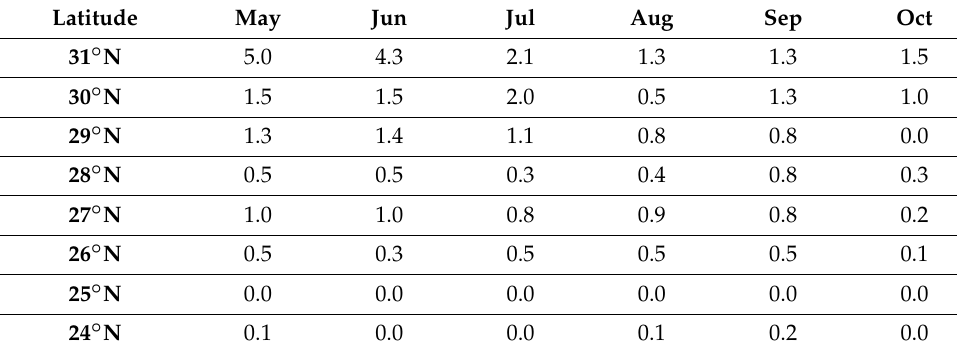
Table 5. Inshore SST—Minimum SST ( ◦ C) during warm seasons.